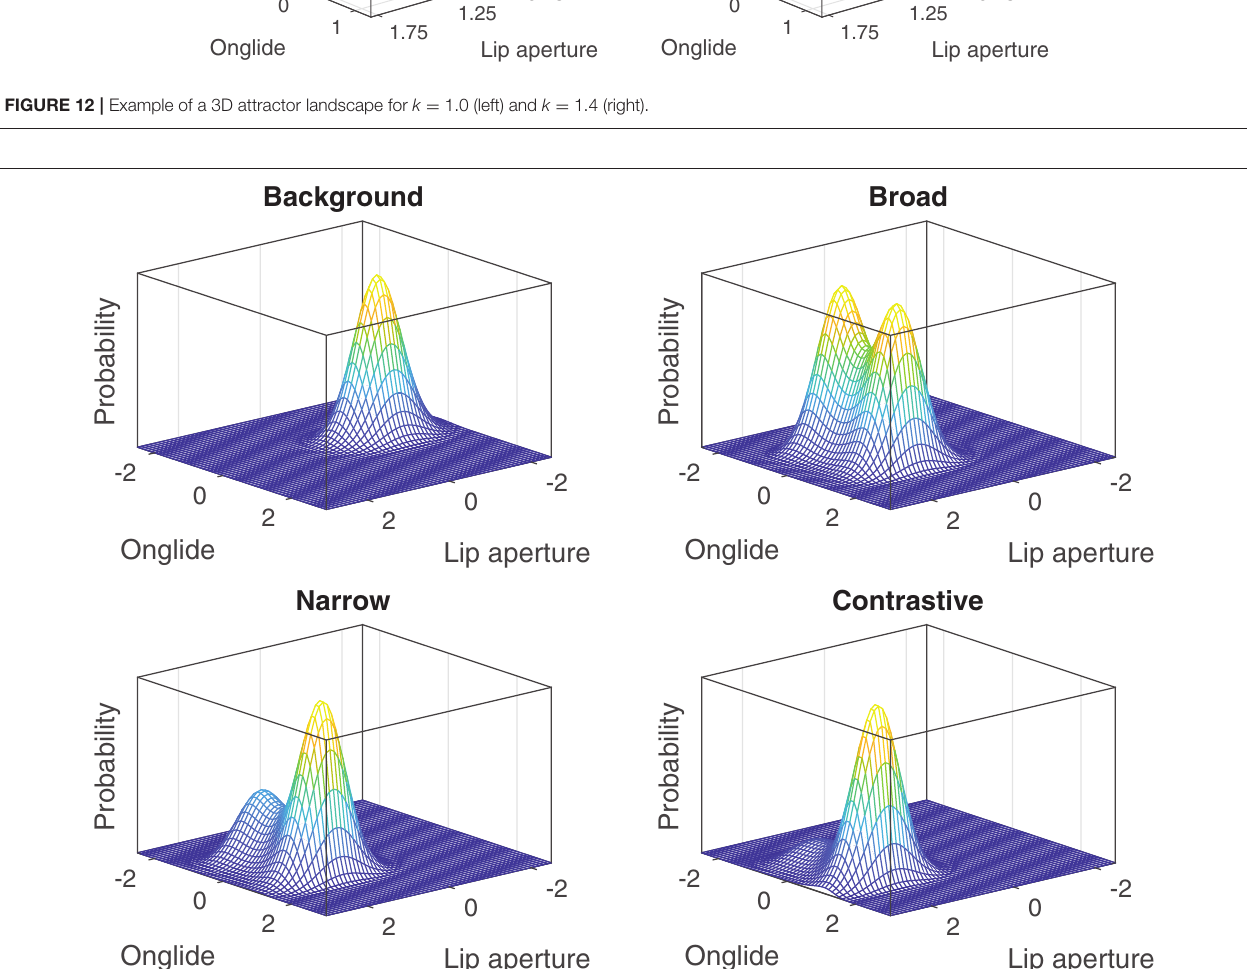
FIGURE 13 | Probability density functions for the system with the k values corresponding to the focus types from top to bottom: background: k = − 1, broad focus: k = 1, narrow focus: k = 1.4, contrastive focus: k = 1.7.